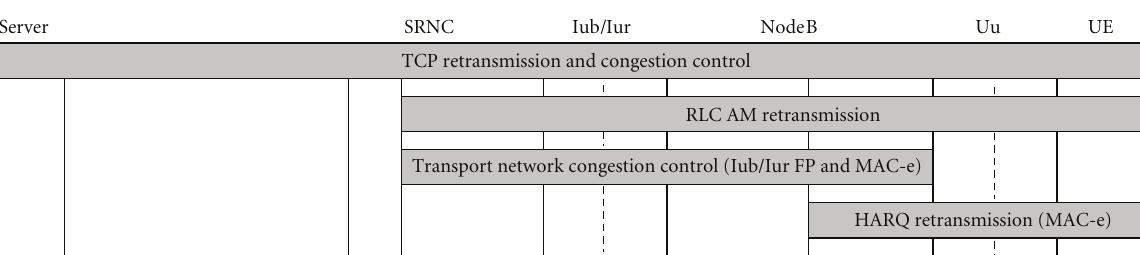
Figure 1: HSUPA protocol stack and flow control architecture.